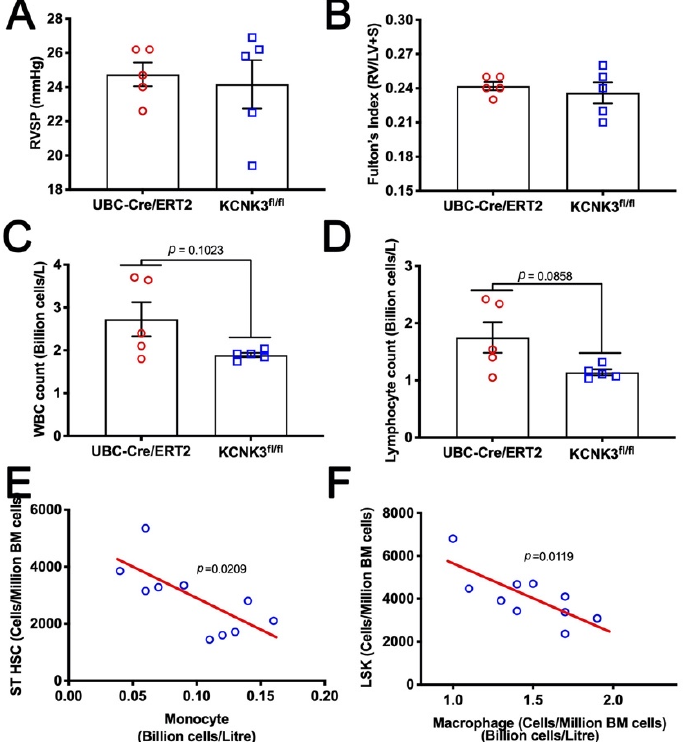
Figure 3. ( A ) High fat diet did not induce pulmonary hypertension in kcnk3 fl/fl mice. All mice carried the UBC-Cre/ERT gene and were Tamoxifen treated. ( B ) High fat diet did not result in right ventricular hypertrophy in kcnk3 fl/fl mice. ( C ) Kcnk3 fl/fl mice trended to lower white blood count than controls. ( D ) Kcnk3 fl/fl mice trended to lower lymphocyte count than controls. ( E ) High short-term hematopoietic stem cells (ST HSC) in the bone marrow correlated to lower levels of monocytes in circulation, implying a high rate of margination and replacement. ( F ) Similarly, high LSK cells in the bone marrow correlate to low macrophage numbers in the circulation. Probability values in panels ( C and D ) are by unpaired t-test; ( E and F ) are by Pearson correlation